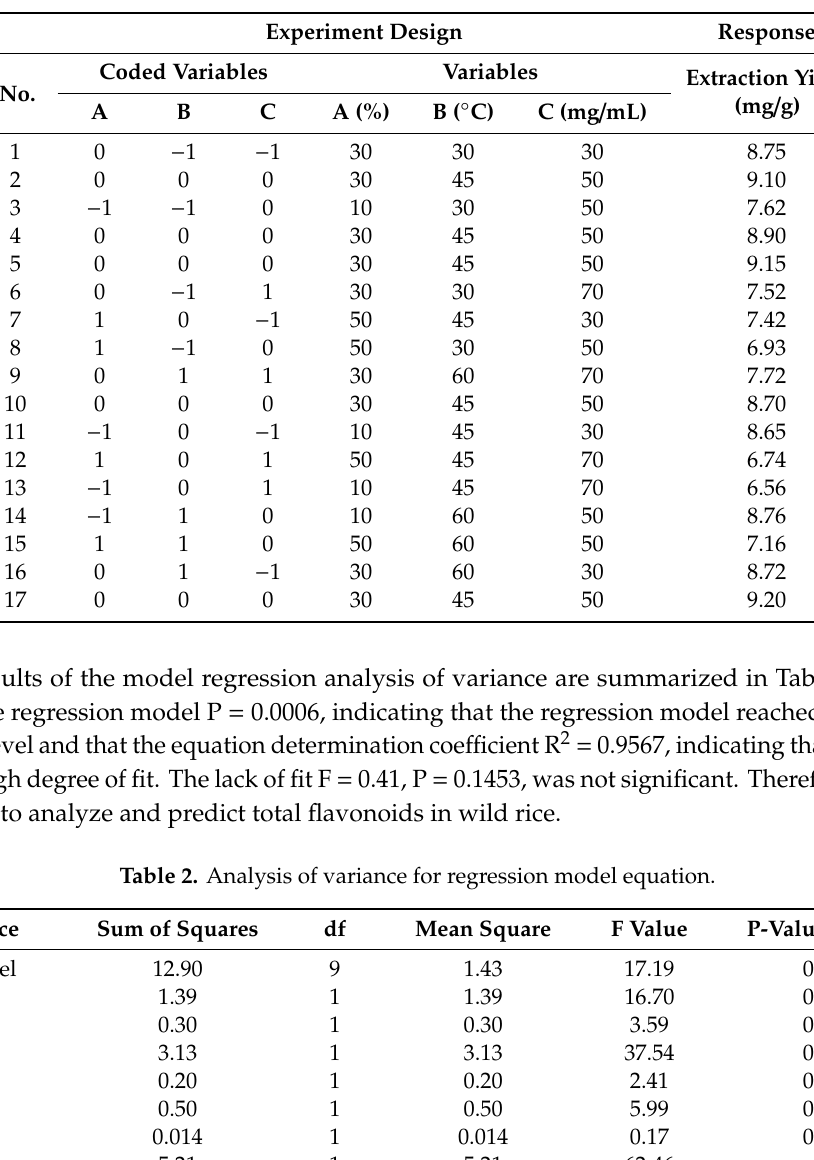
Table 1. Response surface optimization experiments using DES extraction of investigated variables.